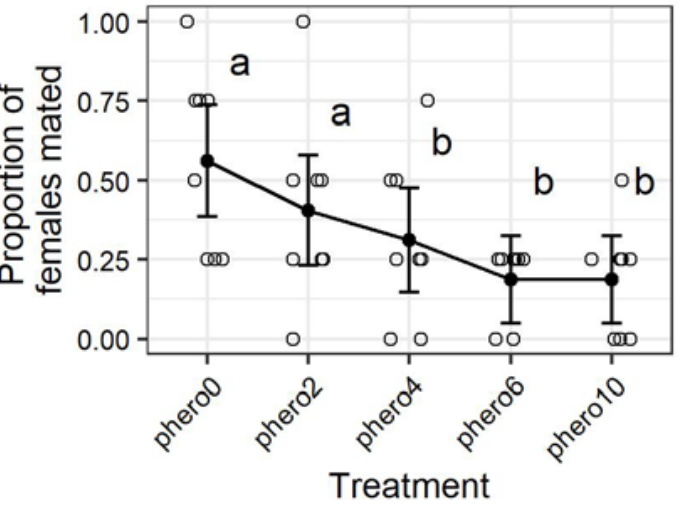
Figure 4. Females mated in 208 L chambers by mating disruption treatment (see Figure 1). Open circles represent individual observations, and the black points and whiskers respectively represent the mean and standard error. Means under different letters are significantly different ( p < 0.05, GLM with binomial distribution).